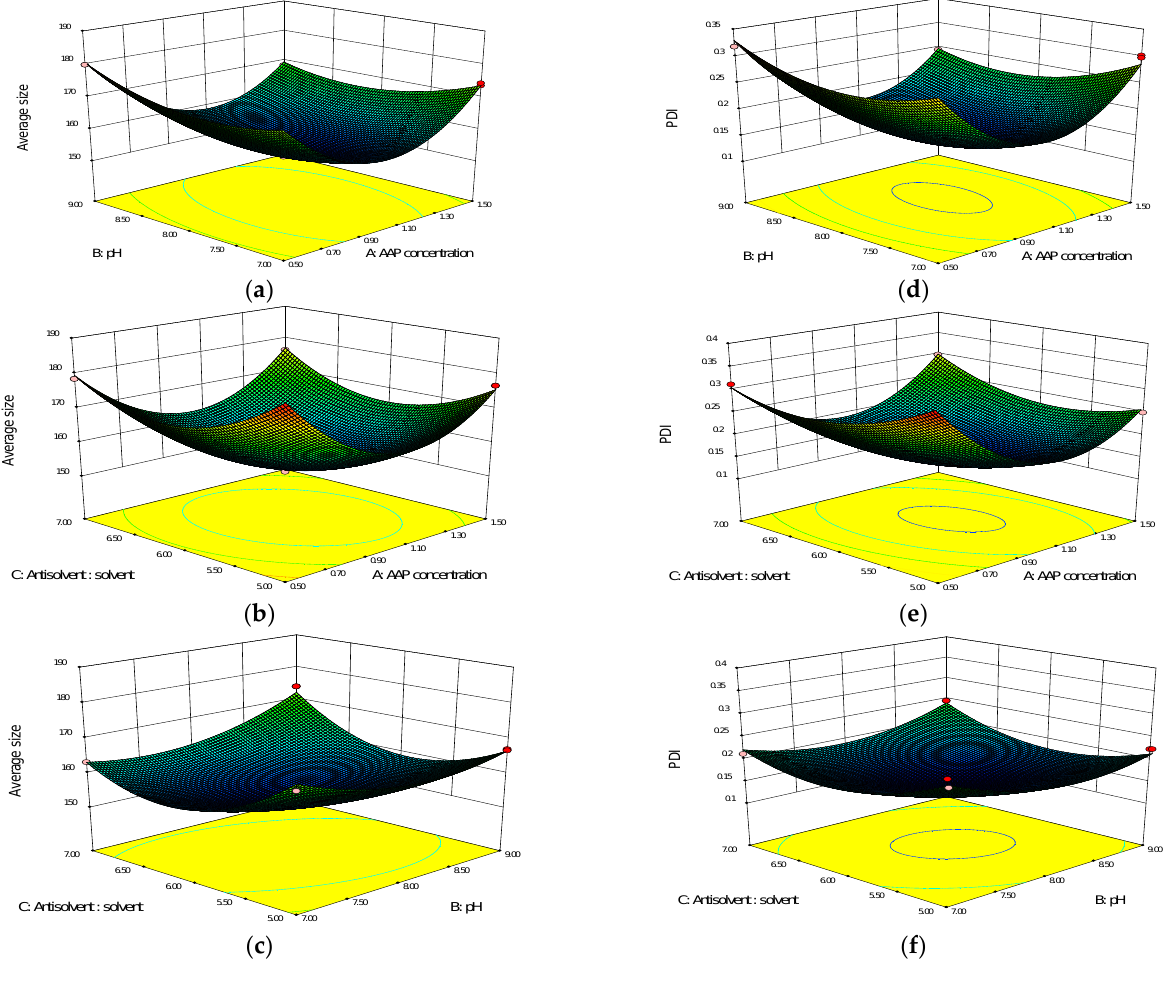
Figure 2. Three-dimensional response surface diagrams of ( a – c ) Model 1 and ( d – f ) Model 2 .